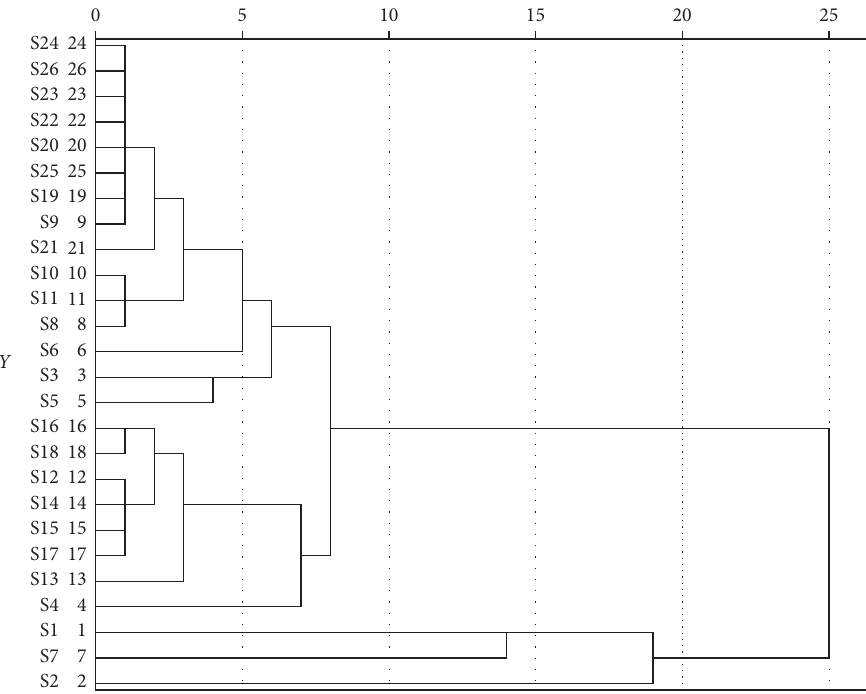
Figure 2: Results of HCA of 26 instant V. anthelmintica